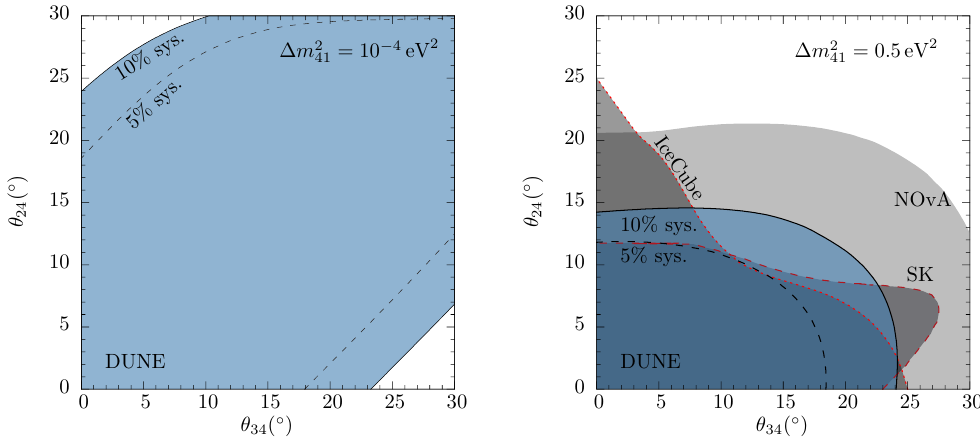
Figure 5 . Expected sensitivity projected in the (cid:18) 24 (cid:0) (cid:18) 34 plane, for an active-sterile mass-squared splitting (cid:1) m 2 = 10 (cid:0) 4 eV 2 (left panel) and for (cid:1) m 2 = 0 : 5 eV 2 (right panel). The shaded regions 41 41 correspond to the expected con(cid:12)dence regions allowed at 90% C.L. (2 d.o.f.), for a simulation assuming (cid:18) i 4 = 0 as true input values. The lines labeled as \10% sys" (\5% sys") have been obtained assuming 10% (5%) prior uncertainties for the signal (both shape and normalization) and 10% for the background (normalization only). For comparison, the right panel shows the latest results from the NOvA experiment from a NC search [28] (gray region), and from atmospheric data from the Super-Kamiokande experiment [4] and IceCube DeepCore data [18] (darker gray regions labeled with red lines), also at the 90%